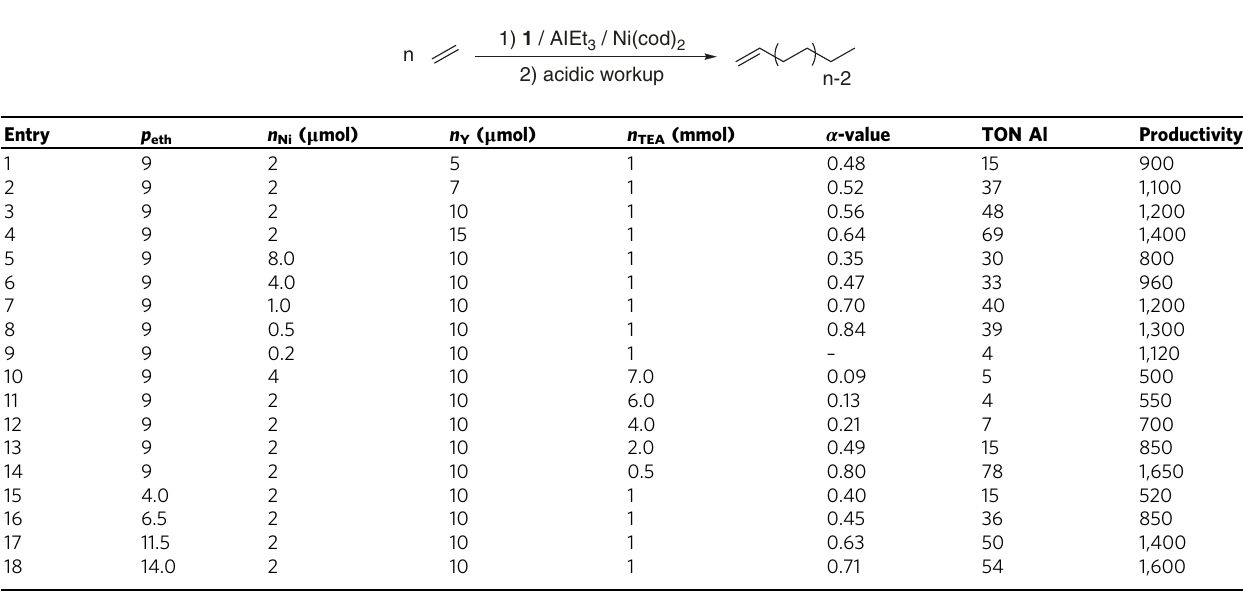
Table 2 In fl uence of the Y and Ni catalysts concentration as well as TEA concentration and ethylene pressure on the α -value, TON Al (formal Al turnover number) and